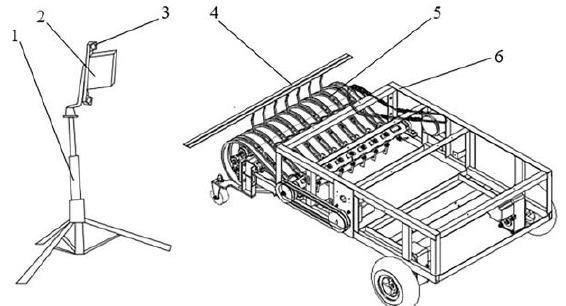
Figure 15. Schematic diagram of quick camera experiment (1: triangular support frame; 2: quick camera; 3: LED filler light; 4: sugarcane leaf; 5: picking mechanism; 6: sugarcane leaf cutting and returning machine).